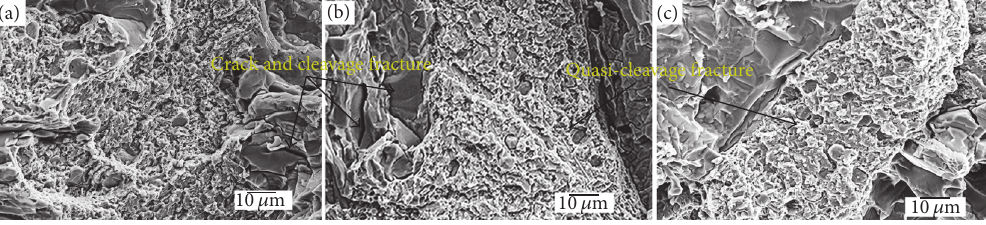
Figure 5: Scanning electron microscopy (SEM) impact fracture micrographs of the specimens after (a) quenching, (b) once tempering, and (c) twice